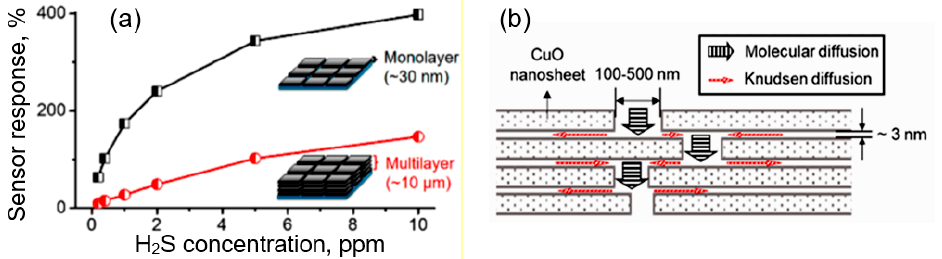
Figure 48. Illustration of the monolayer film formation process using the home-built coater. The red box illustrates that the CuO nanosheets float on the water surface due to the formation of a negative meniscus at the edges and self-assembly due to the attraction force of the same type of meniscus. Reproduced from Miao et al. [406]. Published by ACS as open access. Figure 49. ( a ) Sensor response of monolayer- and multilayer-based sensors to H 2 S; ( b ) model of a multilayer film with lamellar structure. Reproduced from Miao et al. [406]. Published by ACS as open access.